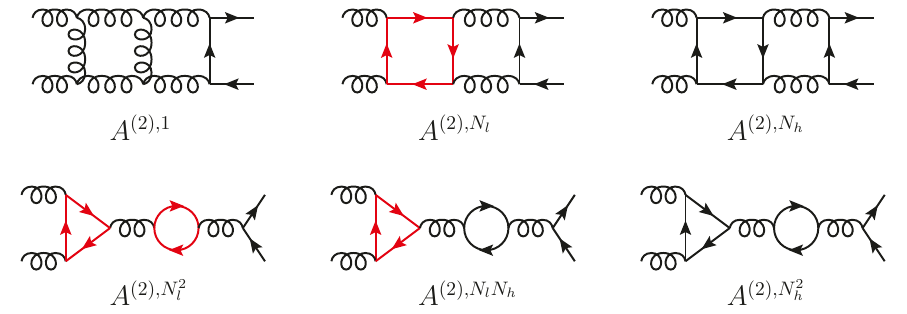
Figure 2. Sample Feynman diagrams corresponding to various internal flavour contributions at two loops as specified in eq. (2.4). Red lines, black spiral lines and black lines represent massless quarks, gluons and top quarks,